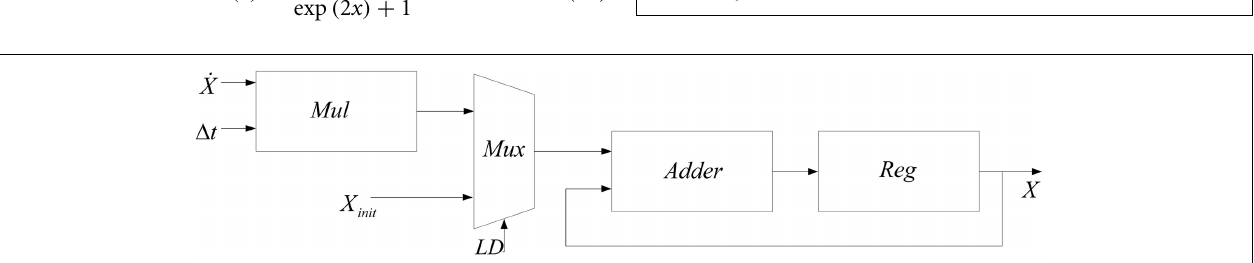
FIGURE 4 | Designed module to implement the gating variable s .